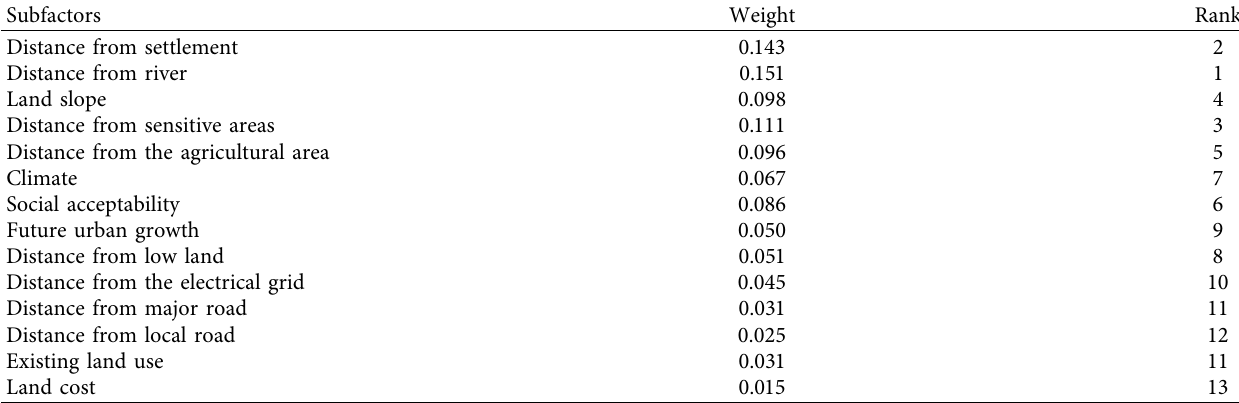
Table 8: The weight on the overall subfactors (CR � 0).